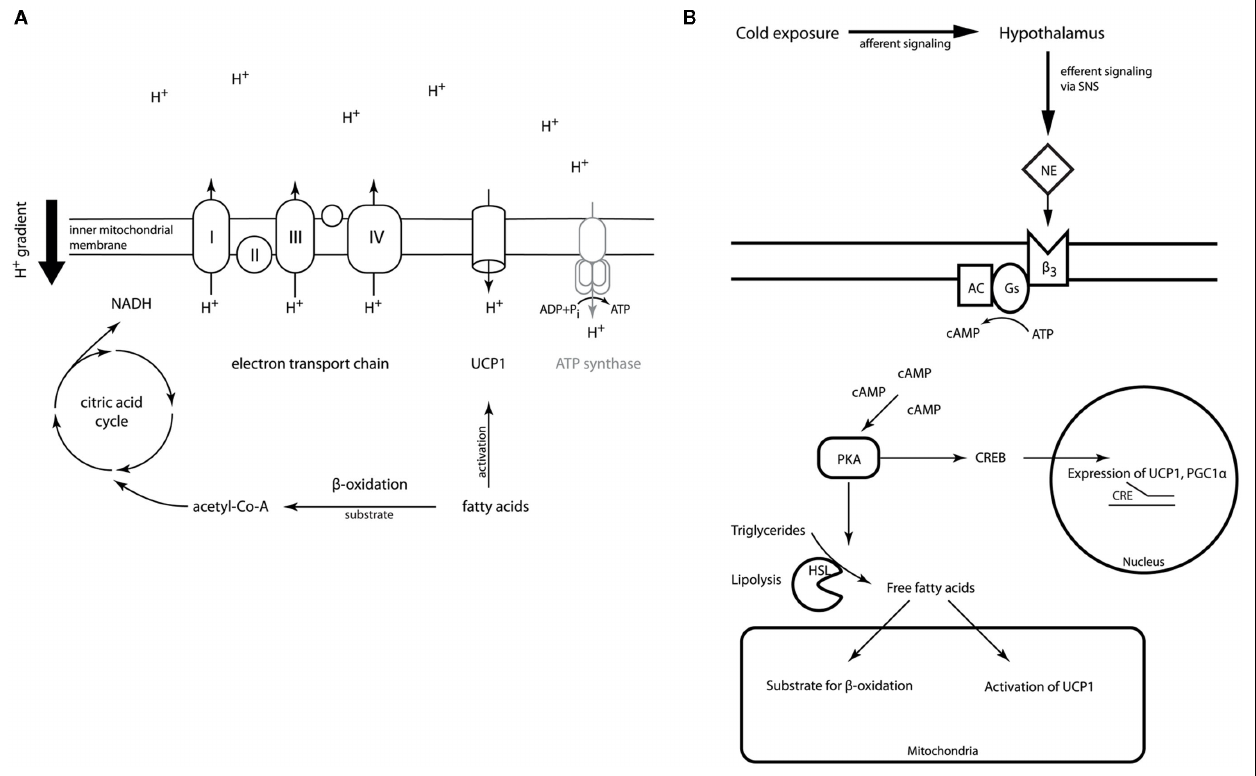
FIGURE 1 | (A) Outline of UCP1 action in brown adipocyte mitochondria.The electron transport chain generates a proton gradient across the inner mitochondrial membrane.This electromotive force is usually drives ATP-synthase restoring the cell’s energy currency ATP. Activation of UCP1 by fatty acids in brown adipocytes dissipates the proton gradient without coupling to ATP regeneration releasing the energy as heat. (Details of the electron transport chain have been omitted for reasons of simplicity). (B) Outline of BAT regulation. Upon cold exposure afferent signals from cold